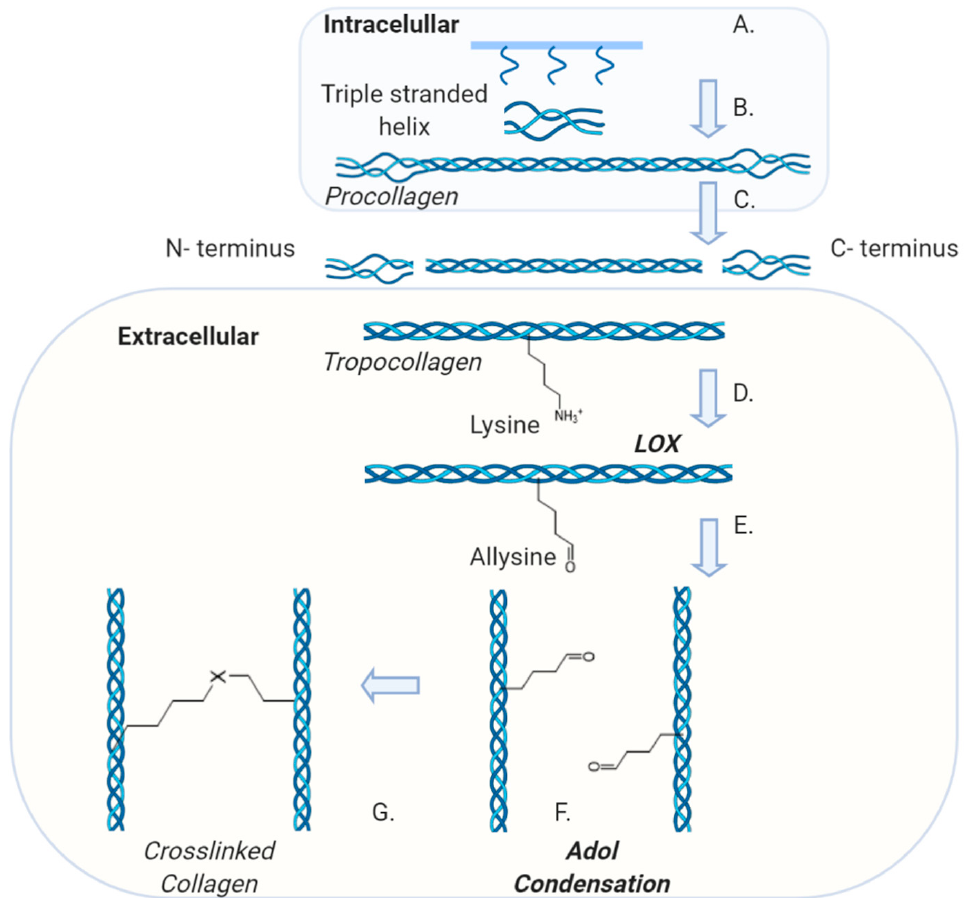
Figure 3. Collagen Synthesis pathway and demonstration of LOX-medicated crosslinks: A. Triple stranded helix is formed in the endoplasmic reticulum (ER) followed by post-translational modification in the Golgi apparatus. B. Procollagen is processed and assembled intracellularly before being secreted to the extracellular space. C. The N and C terminus are removed to form tropocollagen. D. Lysyl Oxidase (LOX) catalyses the deamination of the lysine. E. Conversion of a lysine residue into a reactive aldehyde. F. Aldol condensation reaction between neighbouring aldehyde groups. G. Crosslinks both within and between triple-helical molecules [where X is C =